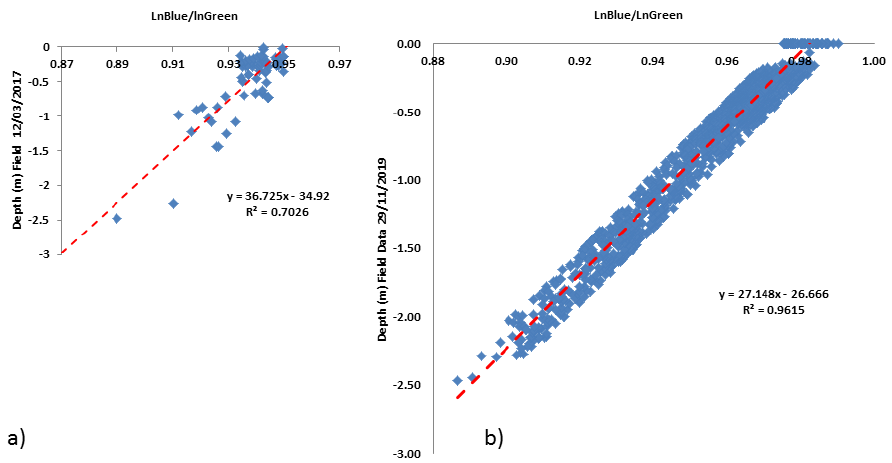
Figure 11. Water Depth Extraction Model for two different water quality conditions: ( a ) 13 March 2017, less water transparency, and ( b ) 29 November 2019, more water transparency.